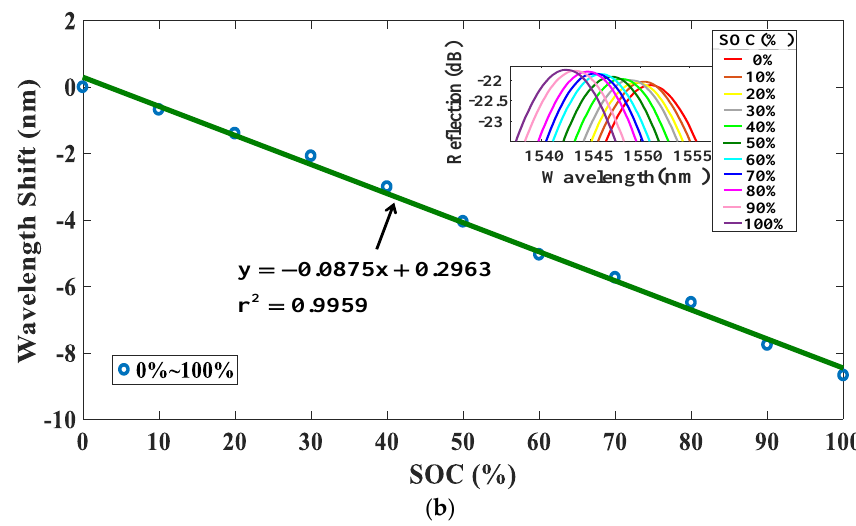
Figure 7. ( a ) Interference spectra of positive electrolytes with 0% – 100% SOC under 25 °C; ( b ) curve fitting of wavelength shift-SOC results in Figure 7a. The inset shows a set of the measured peaks around λ = 1550 nm.